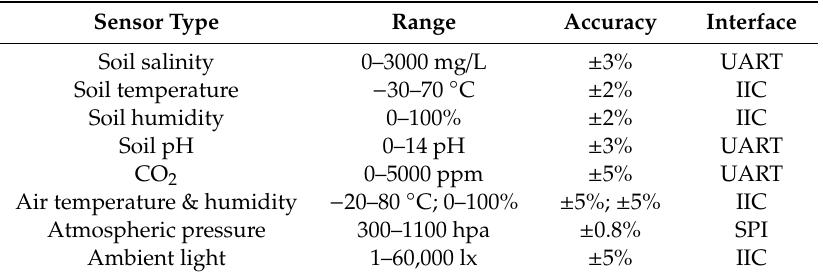
Figure 3. The construction and physical image of wireless sensor network (WSN) nodes. Table 1. The parameters of the sensors.